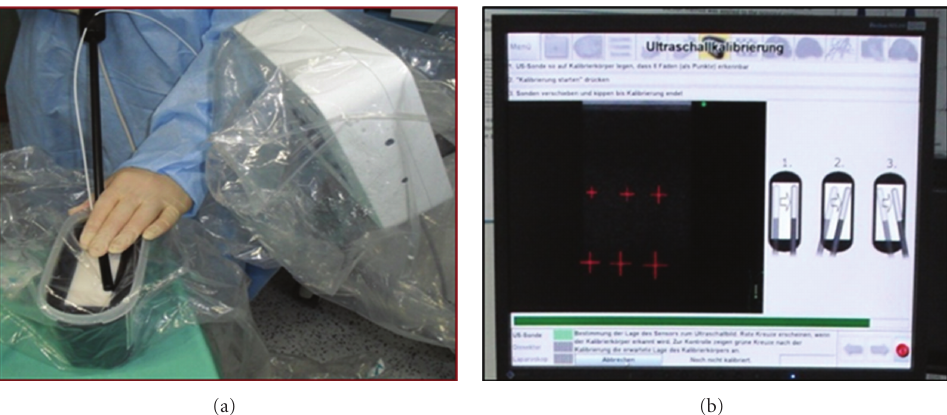
Figure 5: Calibration. (a) Calibration of the ultrasound device by placing it onto the calibrating phantom, (b) calibration process by registered strands in the calibrating